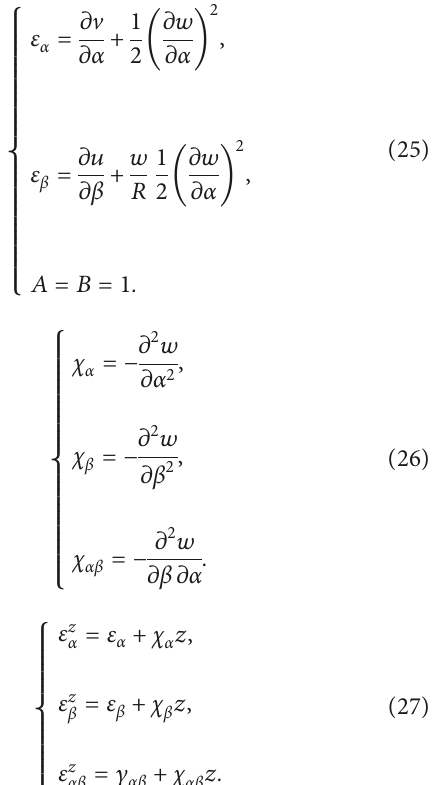
Figure 20: Shell element in curvilinear coordinates α , β , and z